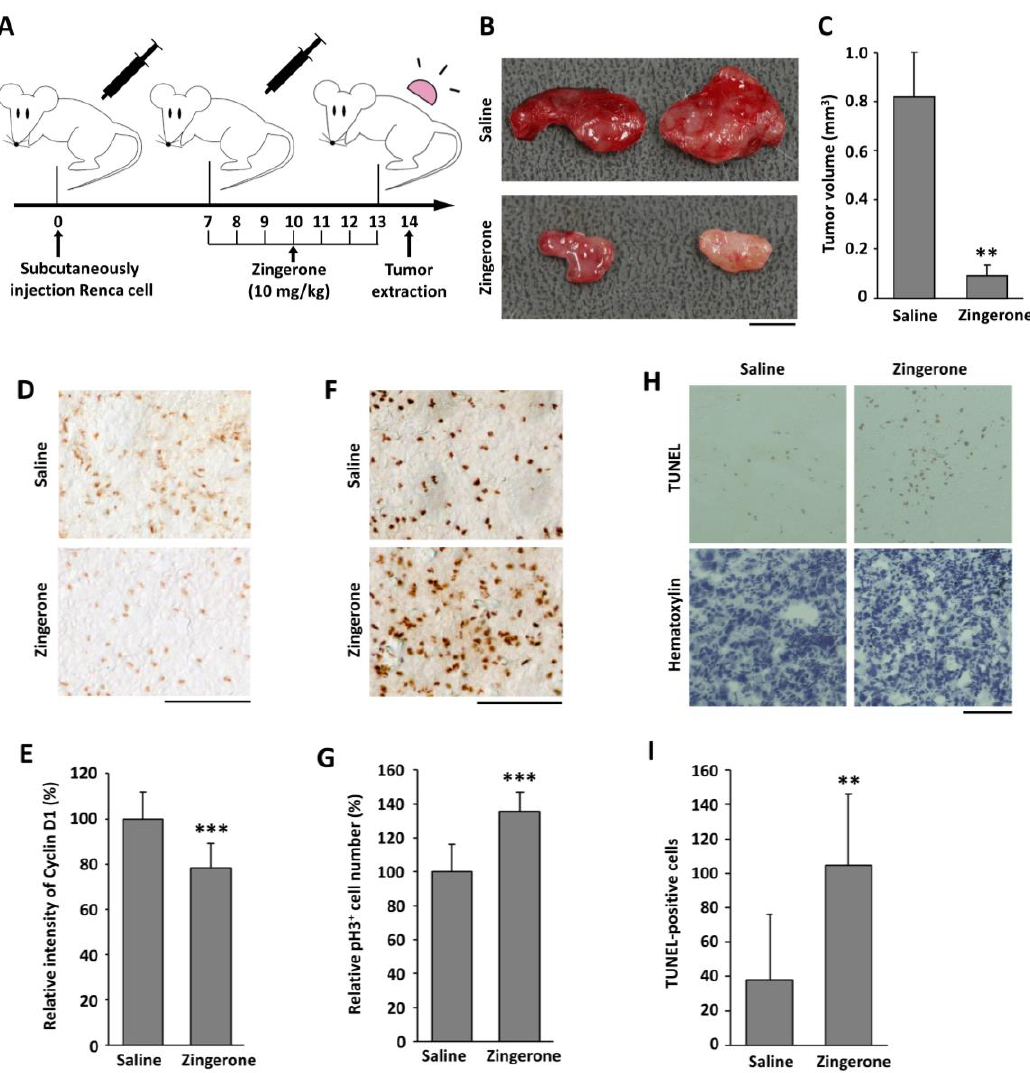
Figure 5. Effect of zingerone on tumor growth and expressions of cell-cycle-regulatory protein in an in vivo mouse tumor model. ( A ) Experimental scheme of the administration. ( B ) Representative picture of tumors from saline-treated mice (upper) and zingerone-treated mice (lower). The scale bar is 0.5 cm. ( C ) Tumor sizes are presented as the means ± SD of three independent experiments with four mice per group. ** p < 0.01 vs. saline. ( D – G ) Immunostaining for cyclin D1 ( D ) and pH3 ( F ) were performed using isolated tumor tissues. The scale bar is 100 µ m. The signals for cyclin D1 ( E ) and pH3 ( G ) were quantified using the ImageJ software (NIH, Bethesda, MD, USA), and the data from three independent experiments are presented as the means ± SD. *** p < 0.001 vs. saline. ( H ) Tumor tissues were stained with terminal deoxynucleotidyl transferase deoxyuridine triphosphate (dUTP) nick end labeling (TUNEL; upper) and counterstained with hematoxylin (lower). The scale bar is 100 µ m. ( I ) The apoptotic cells were counted and quantified from three independent experiments. ** p < 0.05 vs. saline.